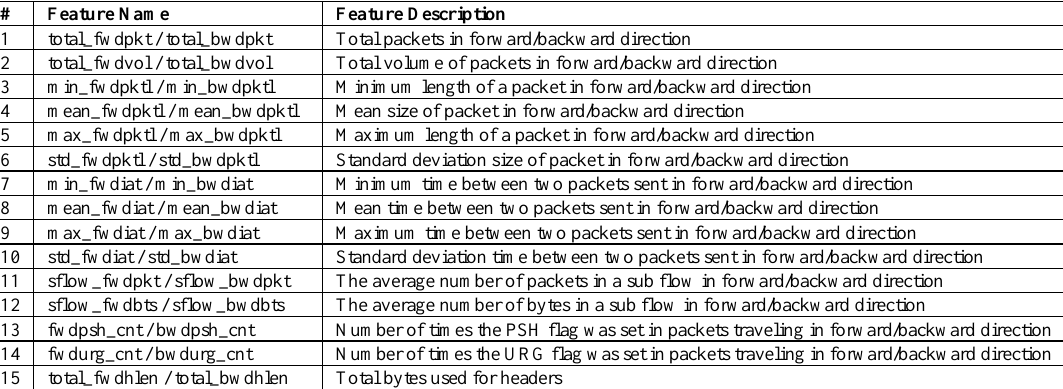
Table 2. Feature description of forward and backward direction packets.